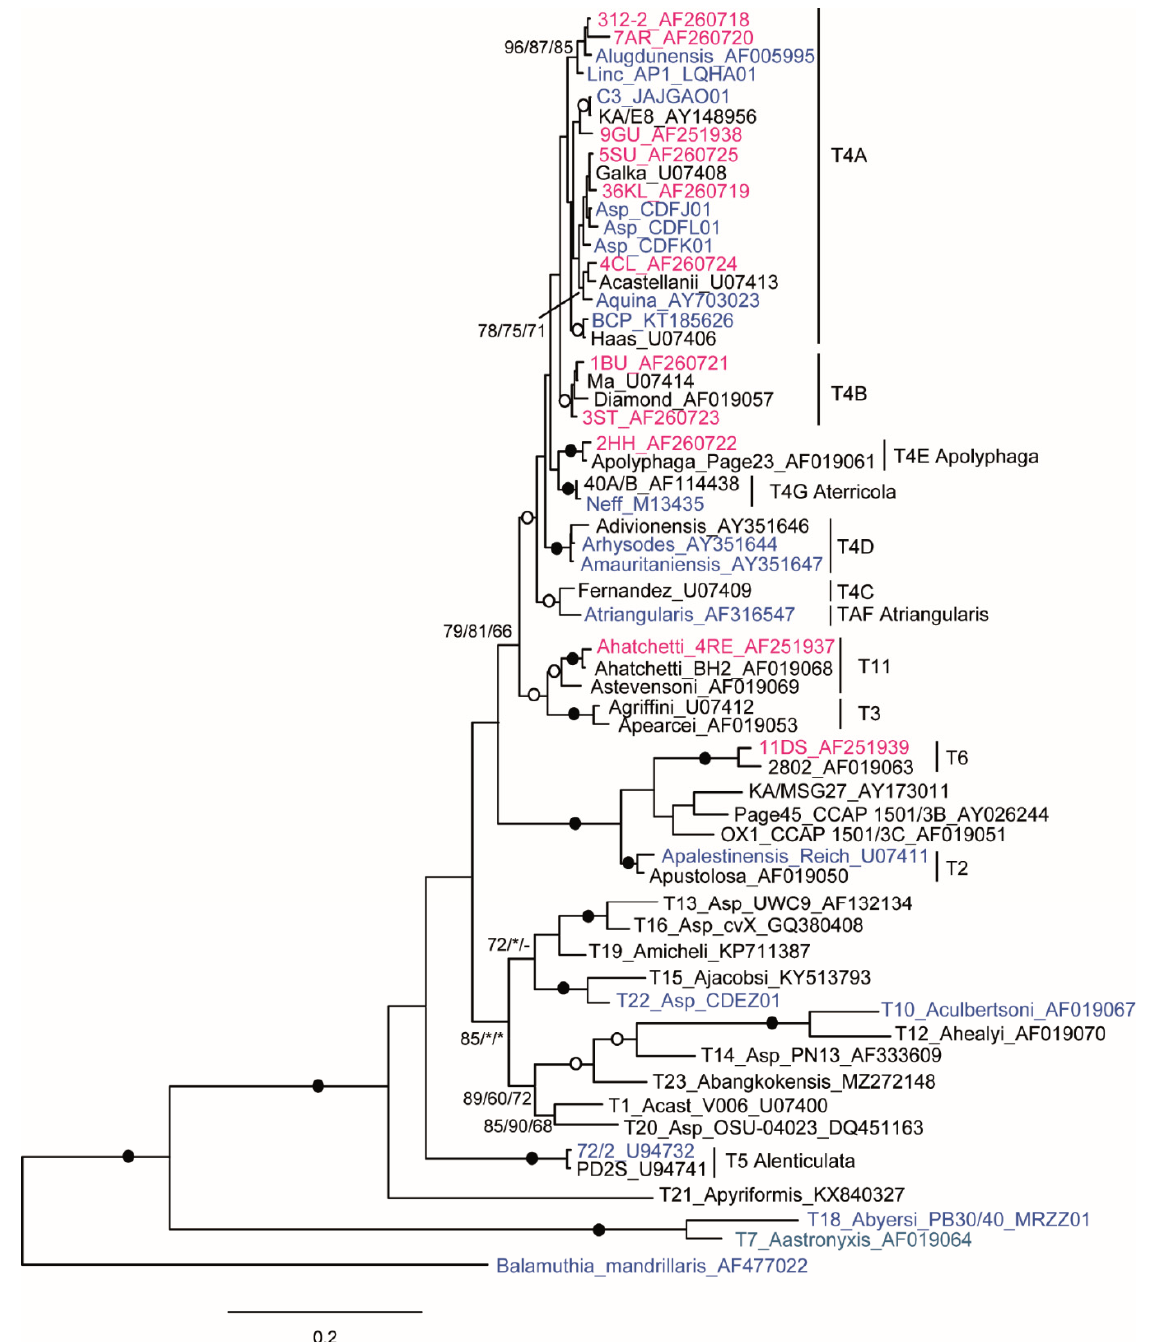
Figure 4. Molecular phylogeny of Acanthamoeba based on complete 18S rDNA. The strains for which ITS-1 alone or the entire rDNA operon is also available are shown in red and blue, respectively. The exceptions are T7, T10, and T22, and the BCP strain of T4A (see Table 1). The tree rooted on Balamuthia mandrillaris ; bootstrap values (1000 replicates) for ML/NJ/MP are shown at the nodes; filled and open circles (100 or >90% support). *, node recovered but support <50%; -, node not